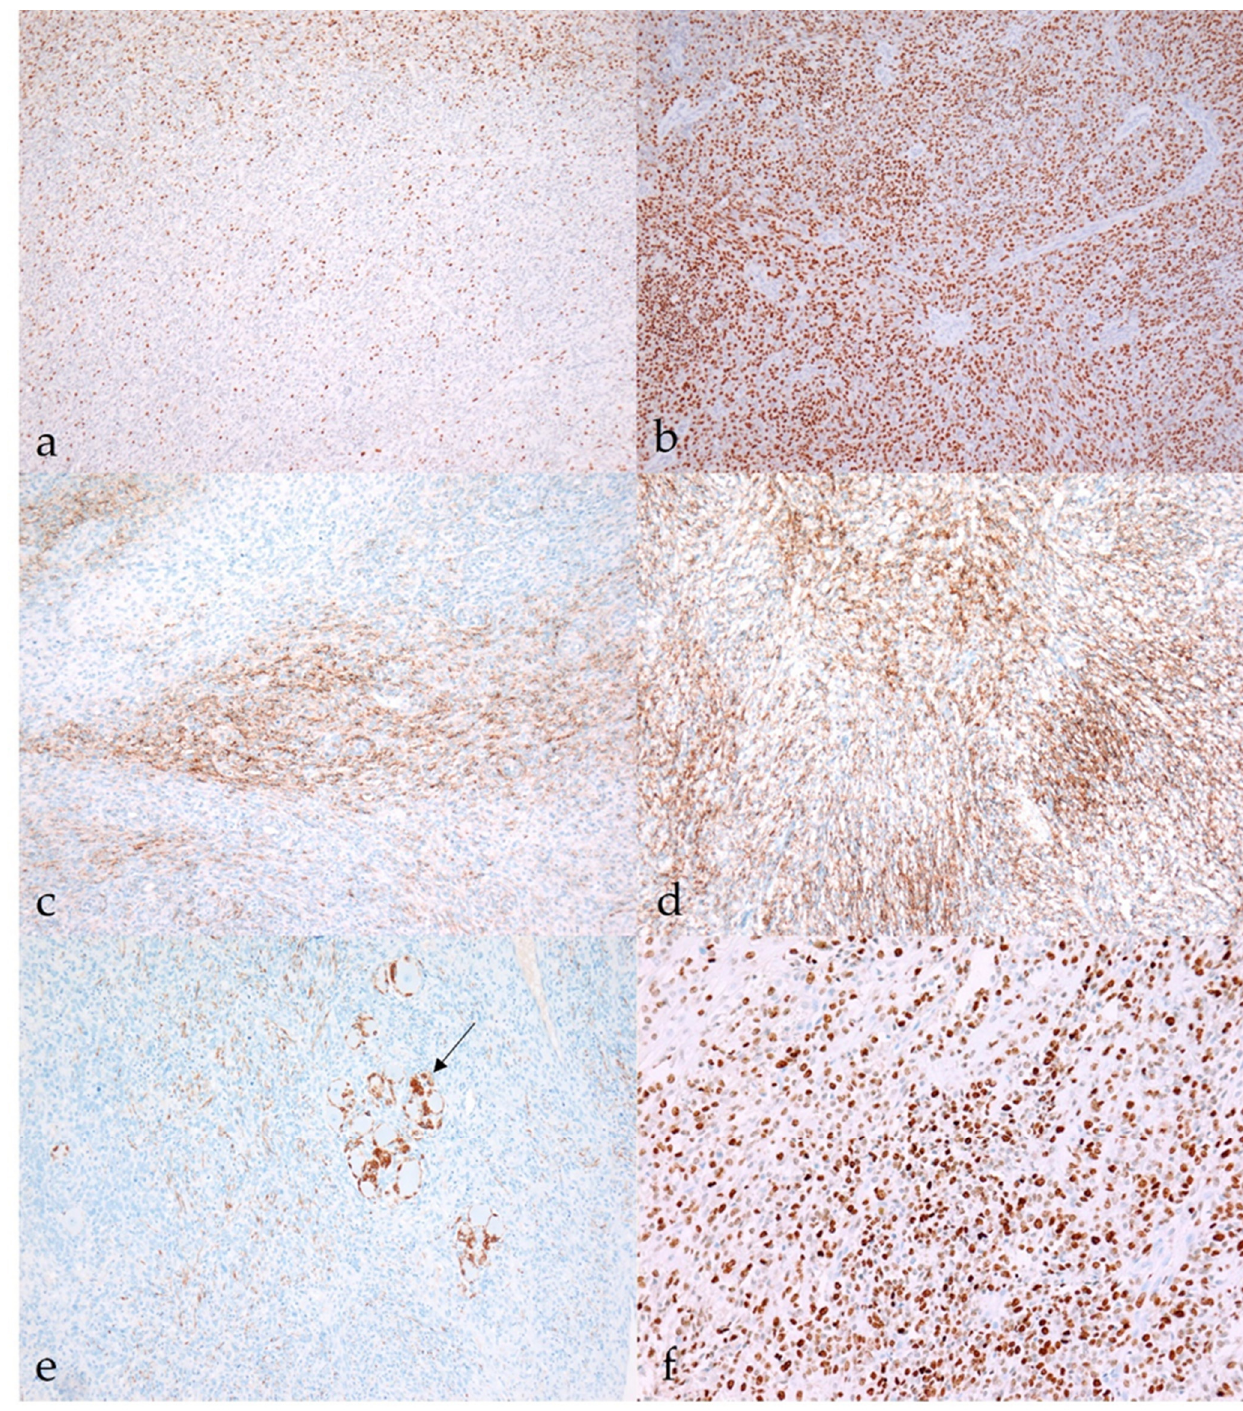
Figure 5. Immunohistochemical characteristics of malignant nerve sheath tumors (MNSTs). ( a ) Moderate nuclear immunoreactivity (++) for Sox10 in conventional MNST (case no. 20). Sox10 , 100×. ( b ) Strong diffuse nuclear immunoreactivity (+++) for Sox10 in epithelioid MNST (case no. 79). Sox10 , 100×. ( c ) Patchy membranous claudin-1 expression (++) in conventional MNST (case no. 69). Claudin-1, 100. ( d ) Strong membranous immunoreactivity (+++) for claudin-1 in MNST with perineurial differentiation (case no. 58). Claudin-1, 100×). ( e ) Moderate cytoplasmic immunoreactivity for GFAP (++) in conventional MNST. Arrow shows GFAP-positive non-neoplastic Schwann cells condensed around neuronal bodies (case no. 21). GFAP, 100×. ( f ) MNST with divergent differentiation had a Ki-67 proliferation index of 70.1% (case no. 39). Ki-67, 200×.